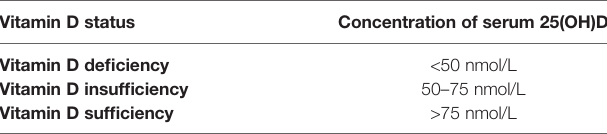
TABLE 1 | De fi nition of vitamin D status. 1 nmol/L = 0.4 ng/mL. Vitamin D